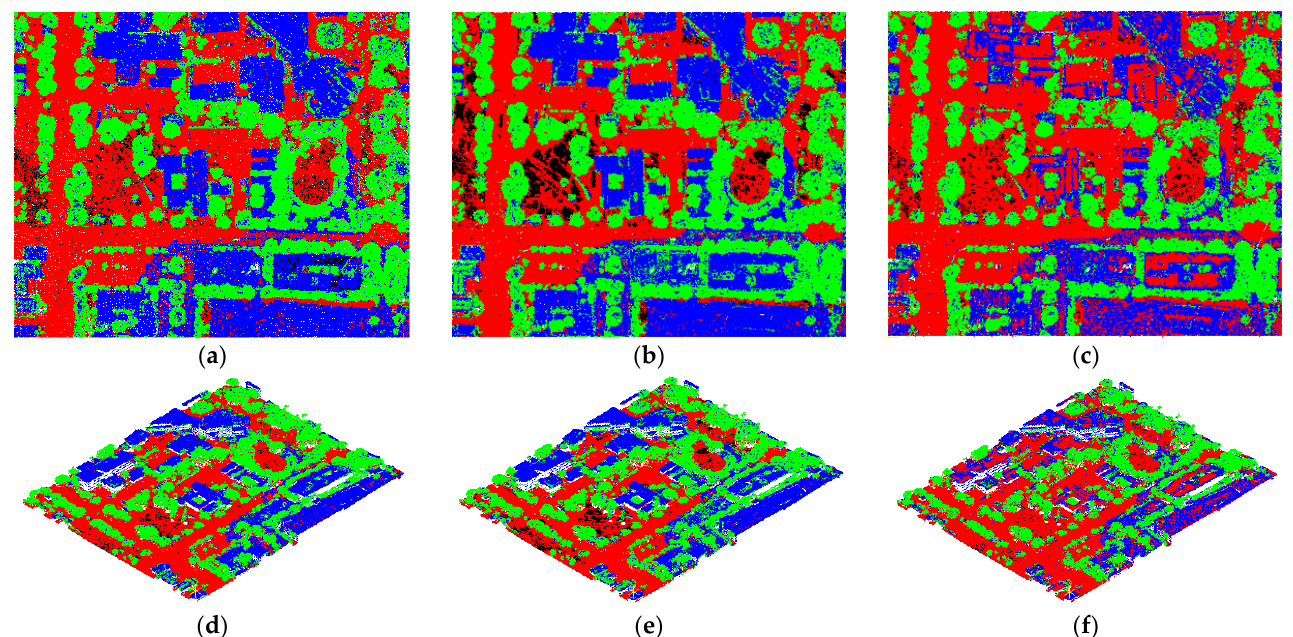
Figure 6. Classification effect of different models in training area A3: ( a , d ) are the classification results of the RF model from a top and side view, respectively; ( b , e ) are the classification results of the DT model from a top and side view, respectively; ( c , f ) are the classification results of the SVM model from a top and side view, respectively.